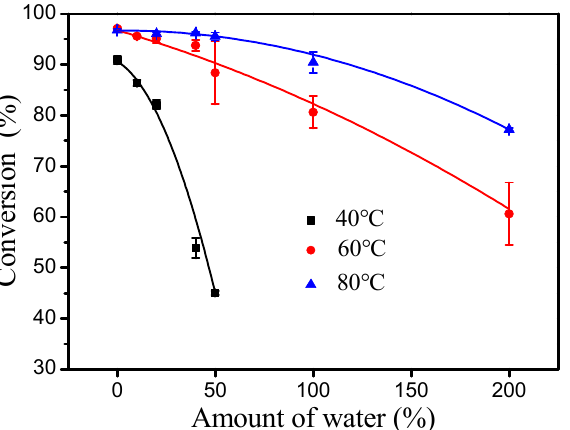
Figure 5. Effect of water content on esterification with DBSA at different temperatures. Reaction conditions: a molar ratio of 1.3:1 oleic acid to alcohol, a reaction time of 4 h and 10 mol% DBSA of cetyl alcohol.